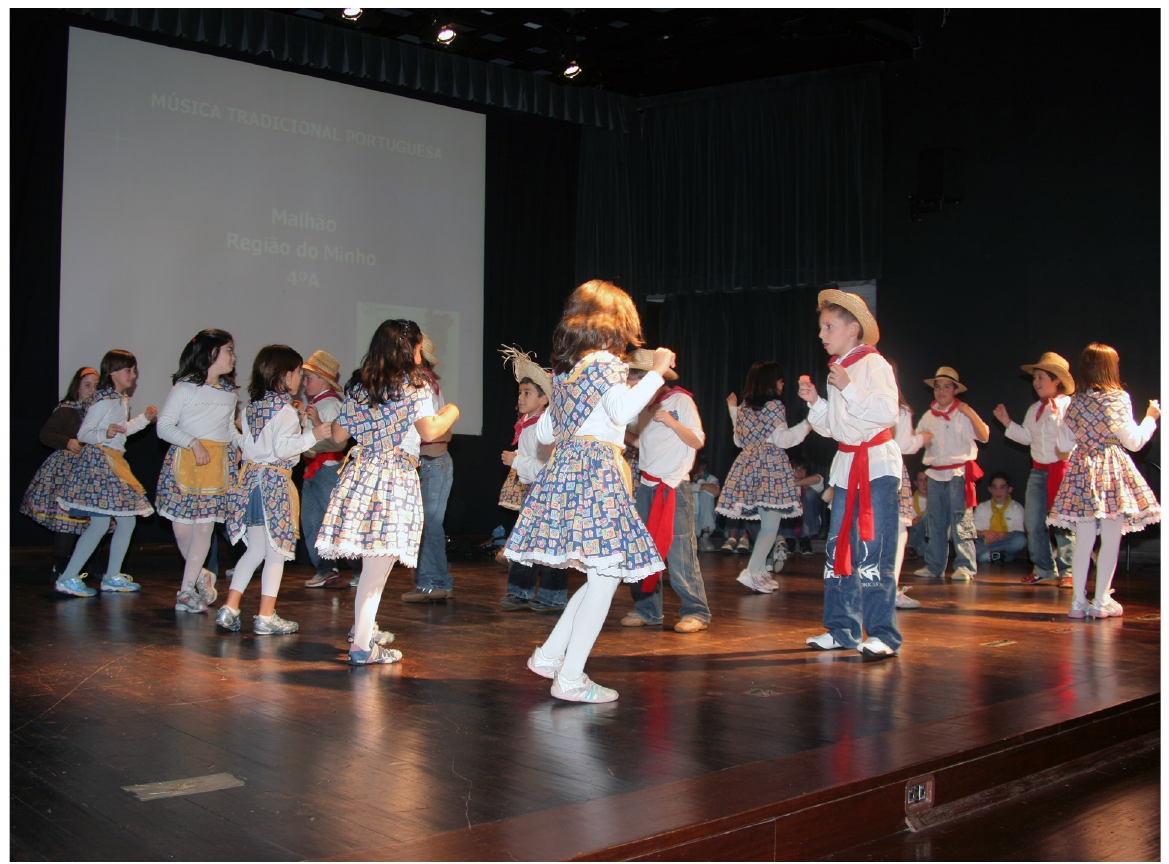
8 | Fig. 8: 4th graders dancing a traditional Portuguese